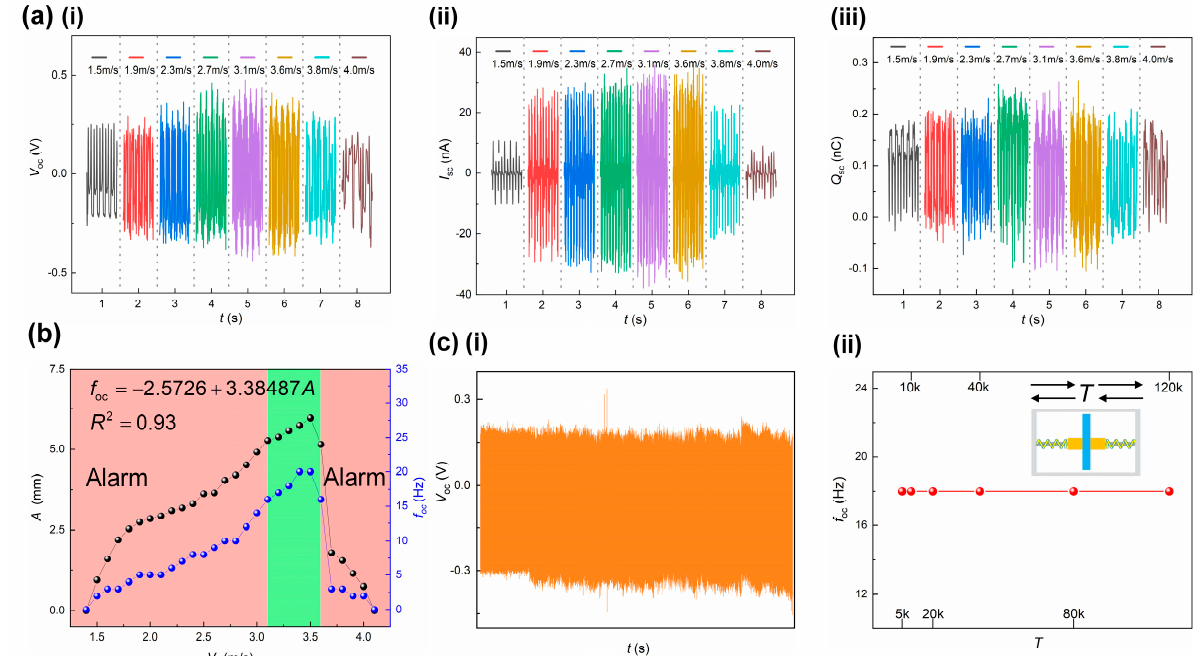
Figure 5. Output performance and durability test. ( a ) The real-time output performance of AVM: (i) open circuit voltage, (ii) short circuit current and (iii) amount of charge transferred; ( b ) the vibration amplitude and output frequency at different gas velocities; ( c ) durability performance: output voltage and frequency at 120,000 vibration repetitions: (i) open circuit voltage, (ii) frequency.